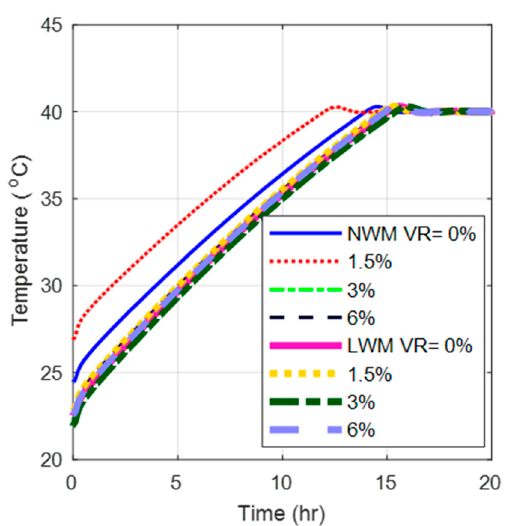
Figure 13. Outside surface temperature variation with time for each specimen.